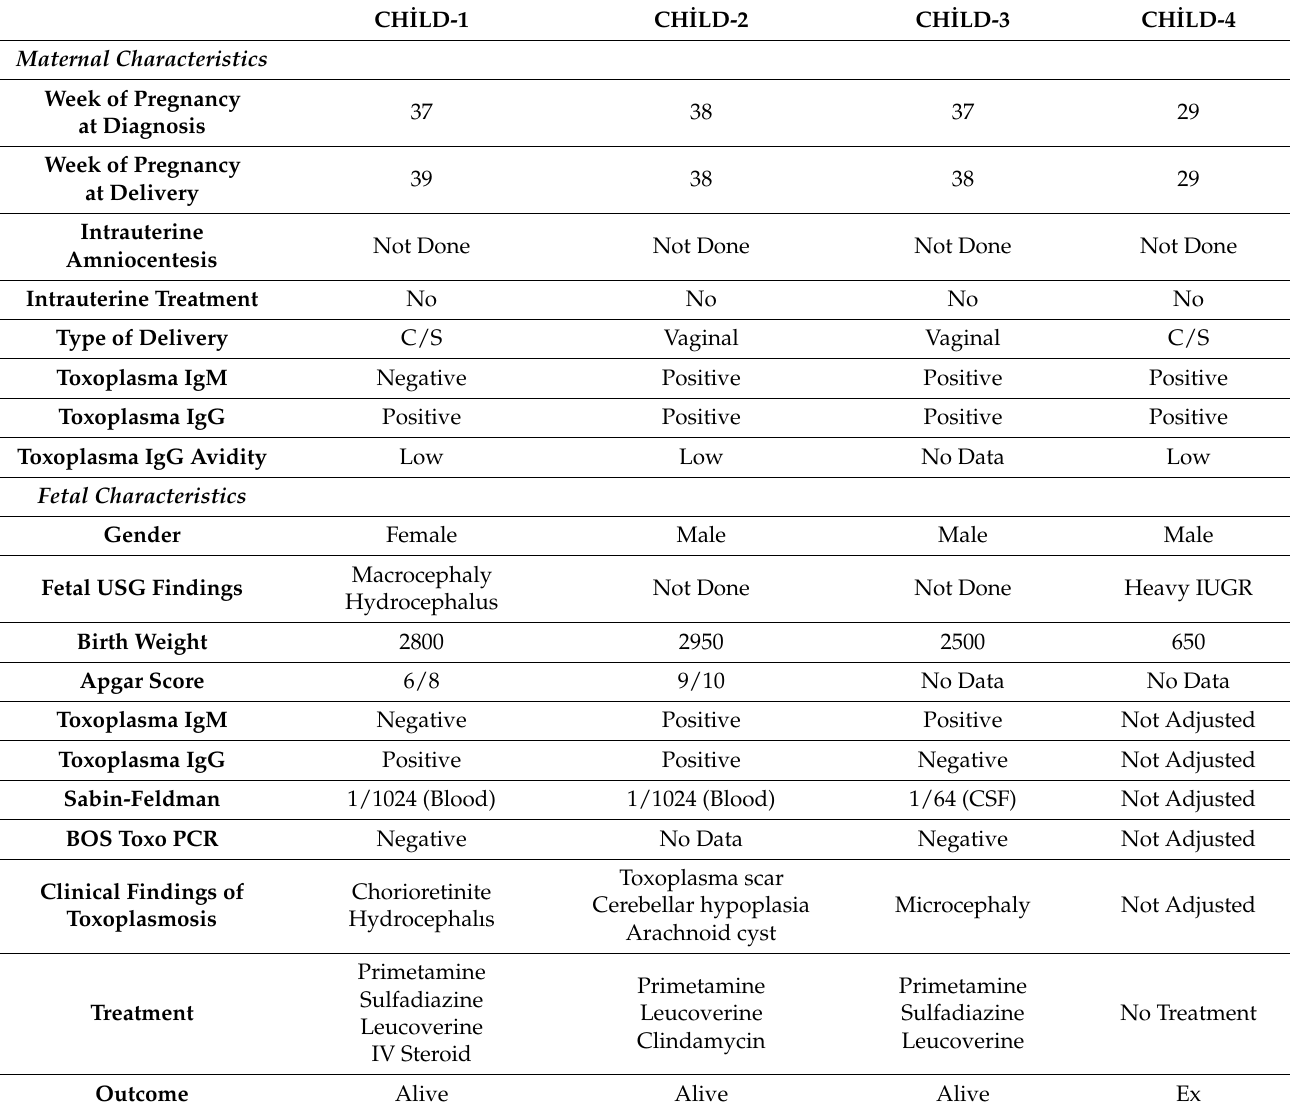
Table 2. Clinical, laboratory and maternal features of children diagnosed with congenital toxoplasmosis.